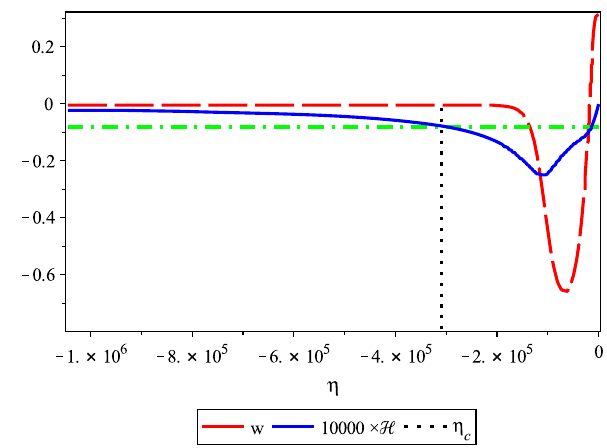
Fig. 3 The evolution of the conformal Hubble parameter H (solid blue line)andequationofstateparameter w (dashredline),versusconformal time η for the case contained H 4 . Green dot-dash line is the crossing Hubble parameter H cr which is occurred by crossing the conformal time, η c with curve H